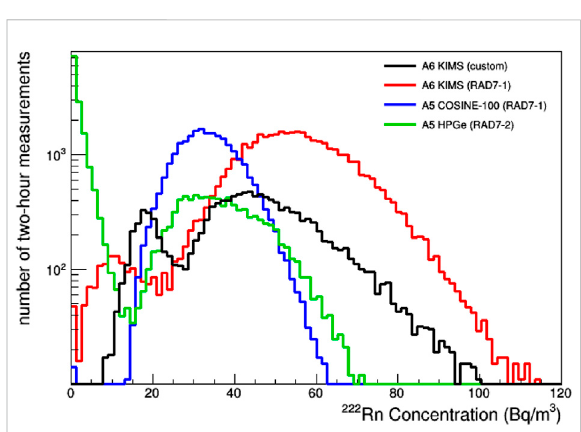
FIGURE 4 The distributions of 222 Rn concentrations in the different Y2L detector rooms. Radon levels were compared among three distinct Y2L experimental areas. A Gaussian fi t is performed on the A6 KIMS lab measurement (red) that has a peak value of 53.4 Bq/ m 3 with a width of 13.9 Bq/ m 3 , The measurements for the A5 COSINE-100 laboratory (blue) have the fi t mean of 33.5 Bq/ m 3 and fi t width of 7.9 Bq/ m 3 . The measurement on the A5 HPGe room (green) exhibits two peaks corresponding to measurements with and without the supply of radon-reduced air. Note that A6 KIMS (custom) measurements also have two peaks and the lowerpeakisduetodifferentventillationconditionexecutedinthe period between middle of 2008 and late